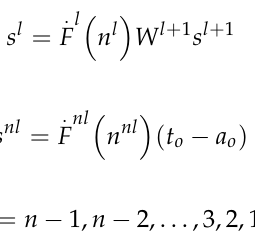
Figure 8. A backpropagation neural network consisting of input, hidden, and output layers [36]. The network error is evaluated at the end of each iteration by taking the difference between the calculated value a 0 and exact value t o . This error is then backpropagated to update the values of weights associated with various neurons. Very often, the error in a layer is given by the weighted sum of the sensitivity. Here, the term sensitivity of the neural network means the change in the output with the variation in the input values. There are a number of algorithms that are used in the literature to give the relation between the sensitivity and error of any layer l of the neural network. One such relation known as the recurrence relation, is given by Equations (13) and (14).